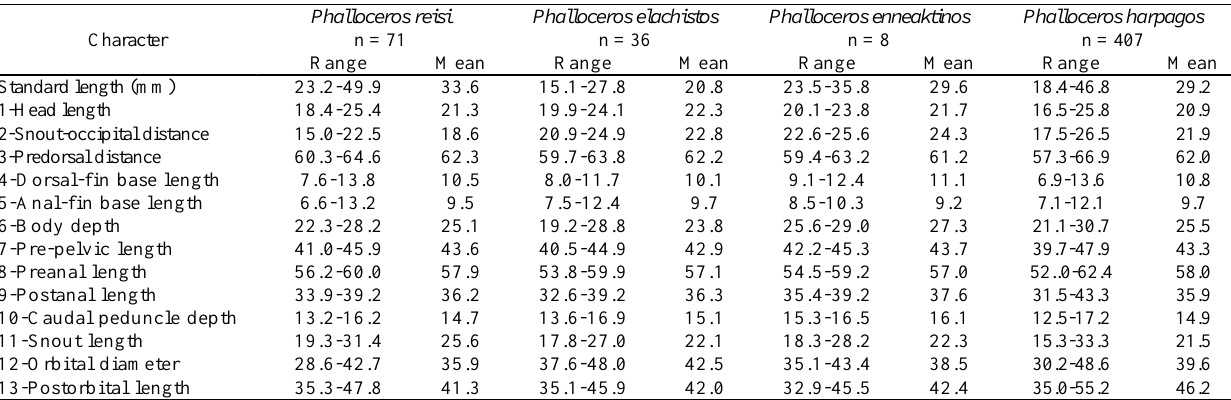
Table 9. Descriptive morphometrics of female specimens of Phalloceros reisi , P . elachistos , P . enneaktinos , and P . harpagos . Measurements 1-10 are percents of standard length and measurements 11-13 are percents of head